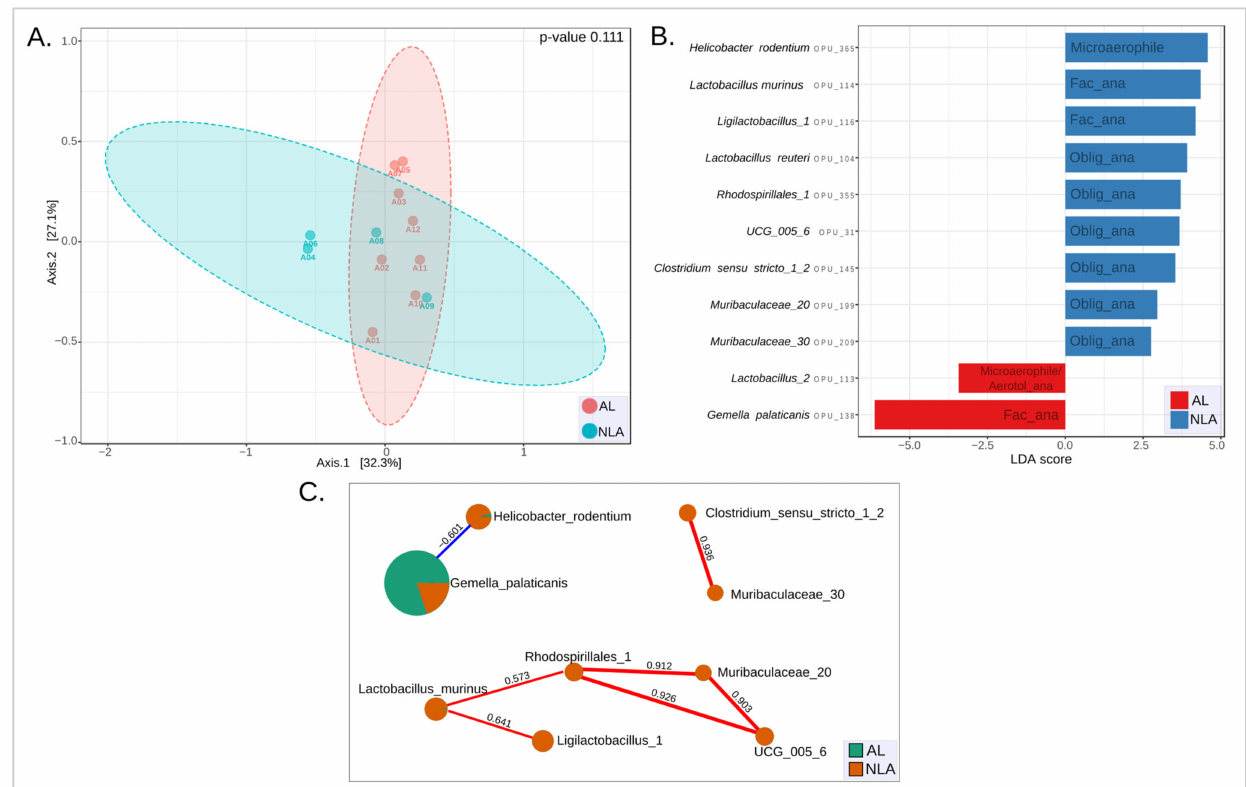
Figure 8. Beta diversity, LEfSe-LDA, and correlation network analyses of NLA and AL groups. ( A ) PCoA of NLA and AL samples using Bray–Curtis beta diversity measures. Statistics: PER- MANOVA. ( B ) LEfSe-LDA score >2 for the identification of species that differ significantly in abundance between groups (raw p -value cutoff <0.05, Kruskal–Wallis test). ( C ) Correlation net- works (SparCC) of 11 species depicted in LEfSe-LDA. Correlation threshold >0.3 and p -value threshold < 0.05 were used. The nodes (pie charts) represent species, size reflects relative abun- dance, with the AL group in green and the NLA group in orange. Positive and negative correlations in red and blue lines, respectively. The thickness of the line represents the strength of the